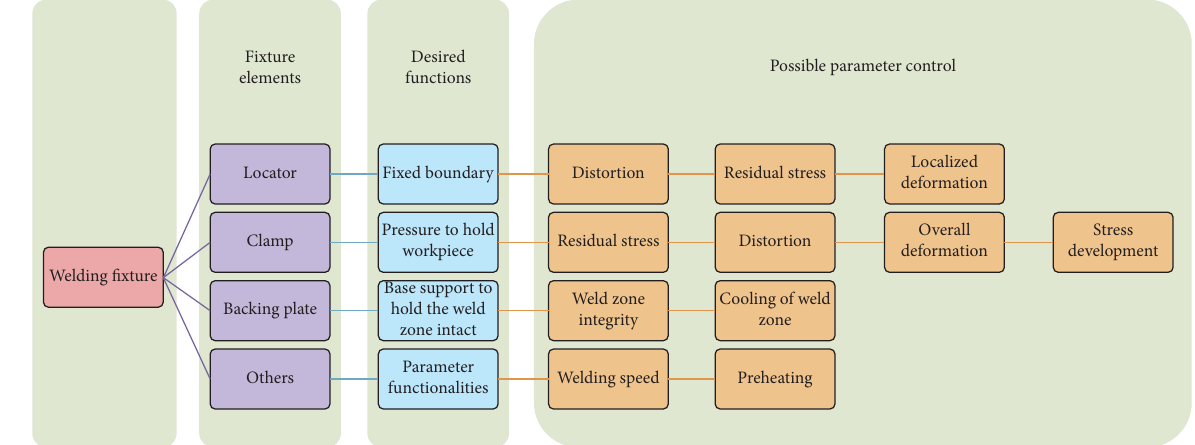
Figure 13: Primary functions of a typical welding